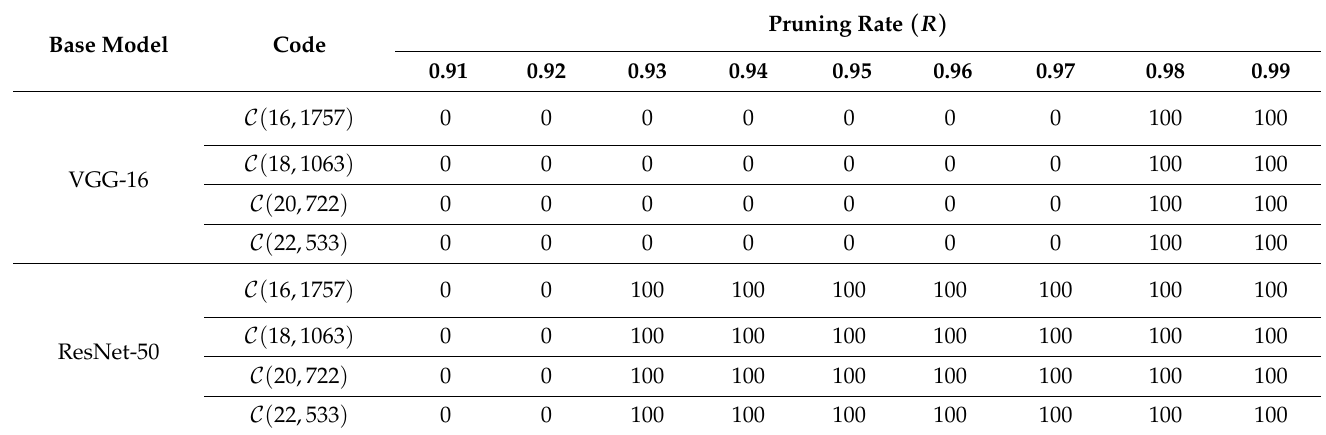
Table 3. Error rate against the pruning